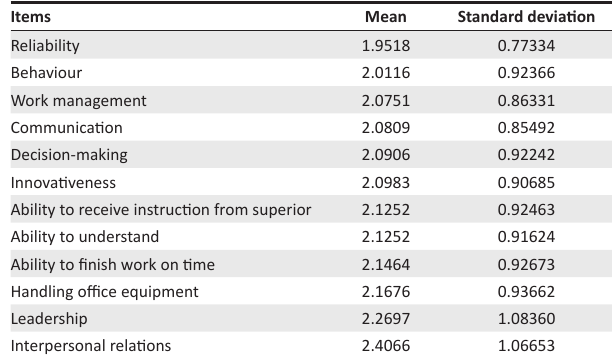
TABLE 3: Employee perception on performance evaluation criteria.